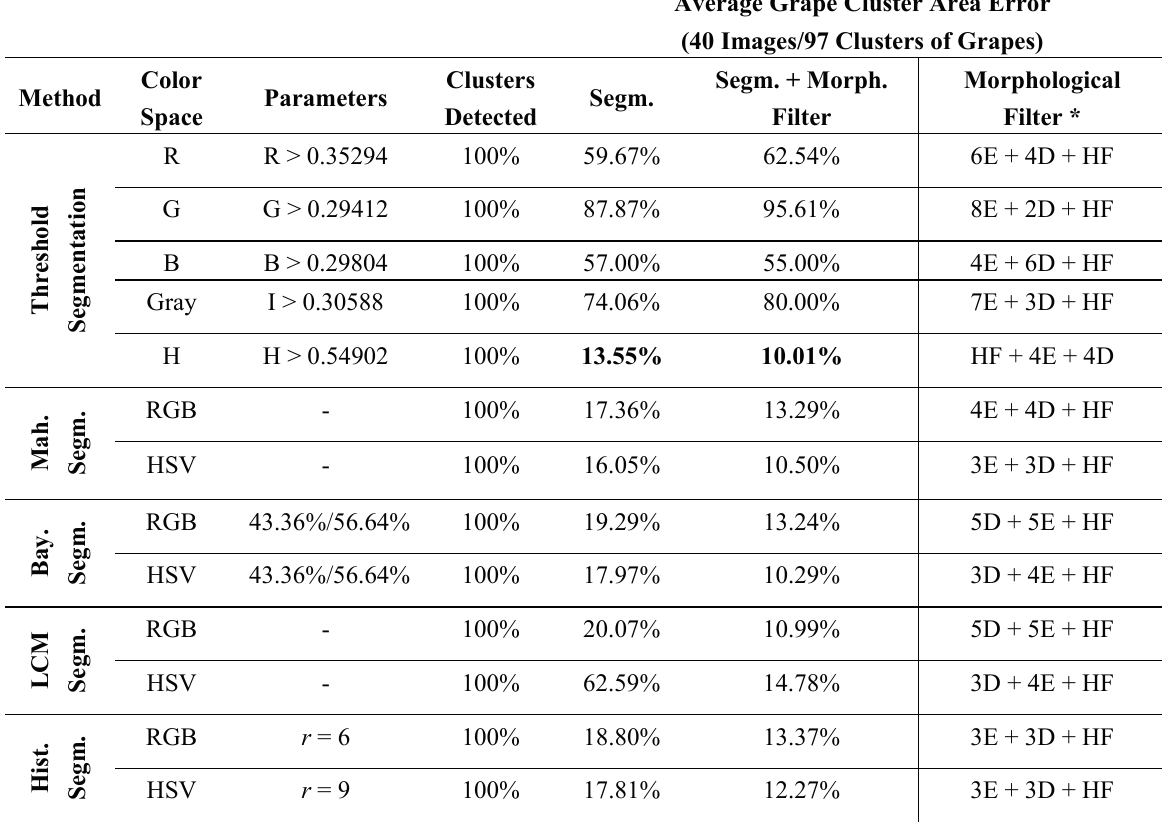
Table 1. Grape cluster size segmentation results obtained in the case of no